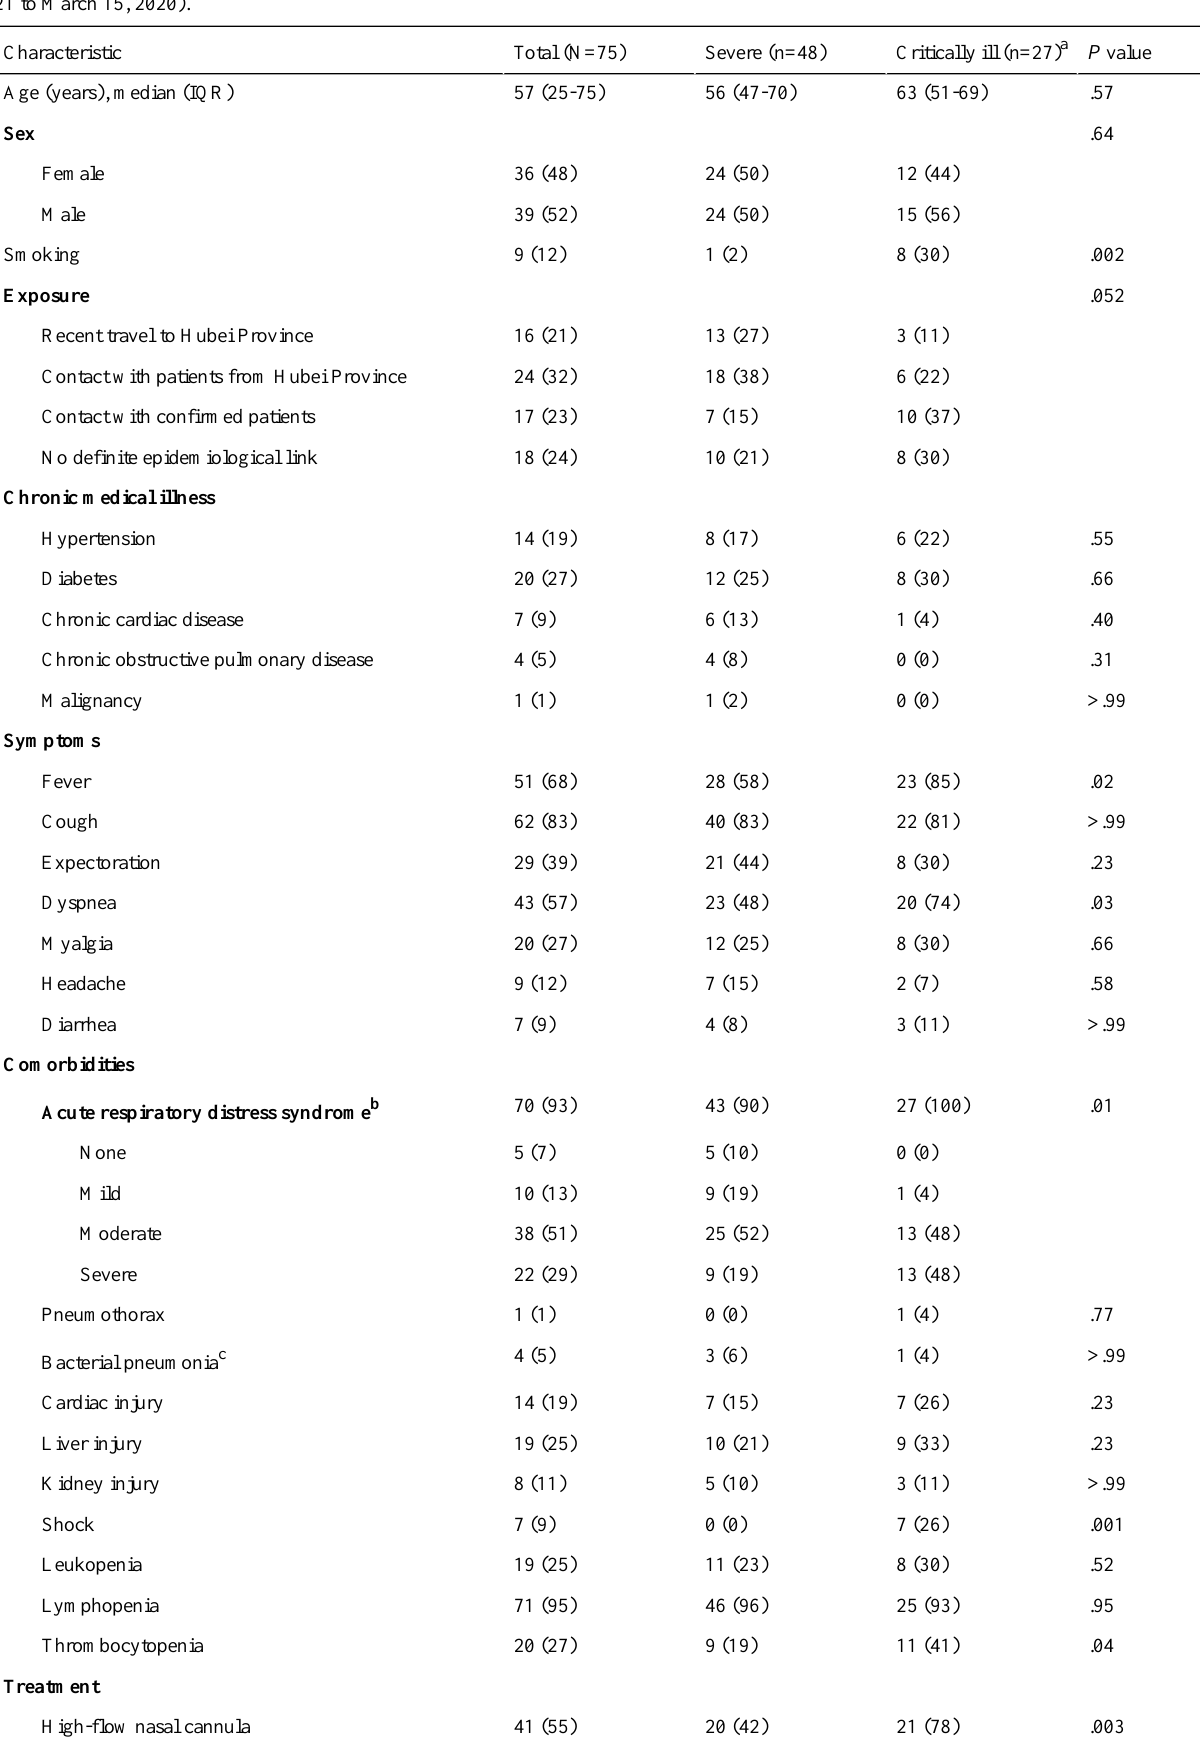
Table 1. Clinical characteristics of severe or critically ill patients with COVID-19 admitted to the intensive care unit in Chongqing, China (from January 21 to March 15,